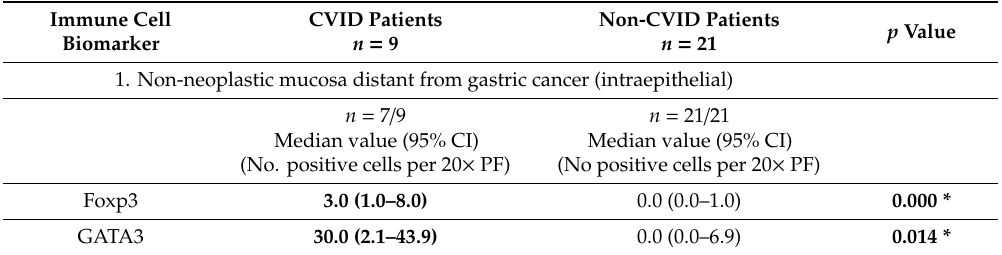
Table 2. Immune cell infiltration (Foxp3, GATA3, CD4, CD8, CD20, CD138) in intraepithelial and stromal compartments of non-neoplastic mucosa (“distant from” and “adjacent to” gastric cancer) and in gastric cancer of CVID cases in comparison with non-CVID